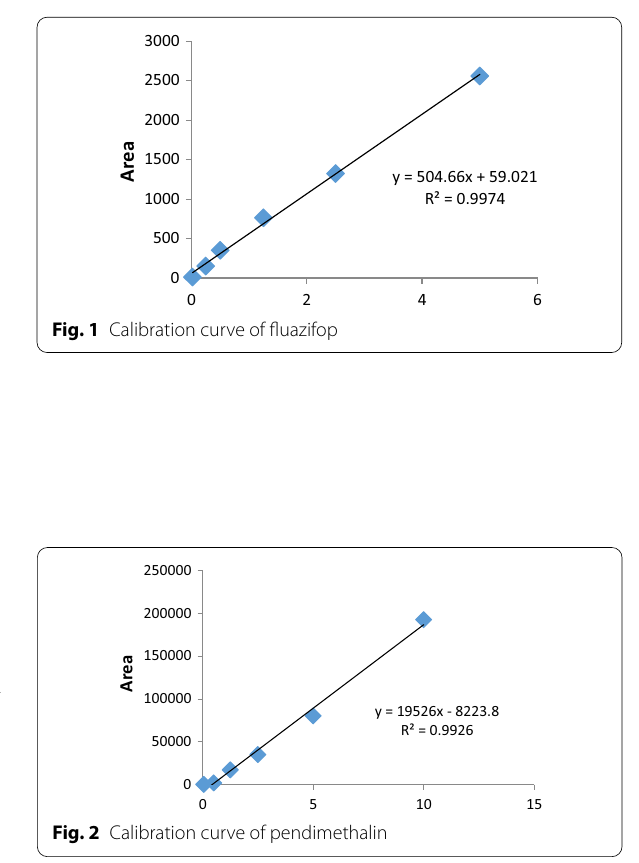
fluazifop butyl at the +